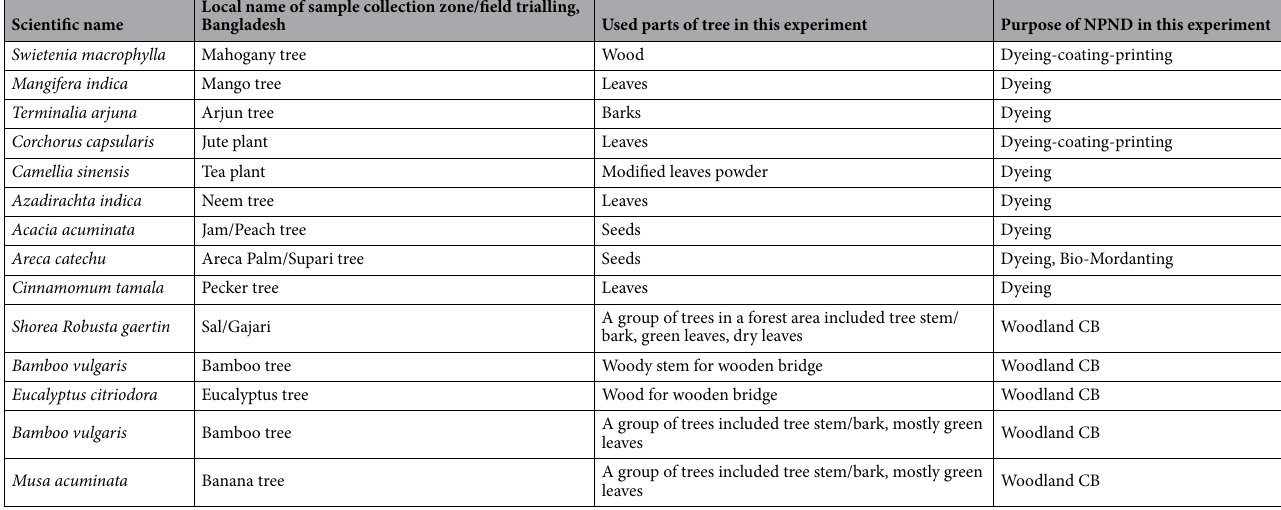
Table 1. Experimental applications of selected NPND-materials for three-dimensional process of camouflage formulation and coloration (dyeing-coating-printing) and selected forest plants/herbs for comparison with woodland